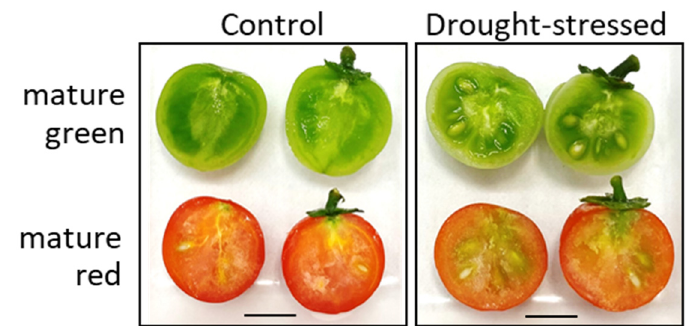
Figure 1. Photographs of the tomato fruits used in this study. Mature green fruits and mature red fruits were subjected to mass spectrometry imaging. All tomato fruits were harvested at 10 a.m. The scale bar indicates 1 cm.